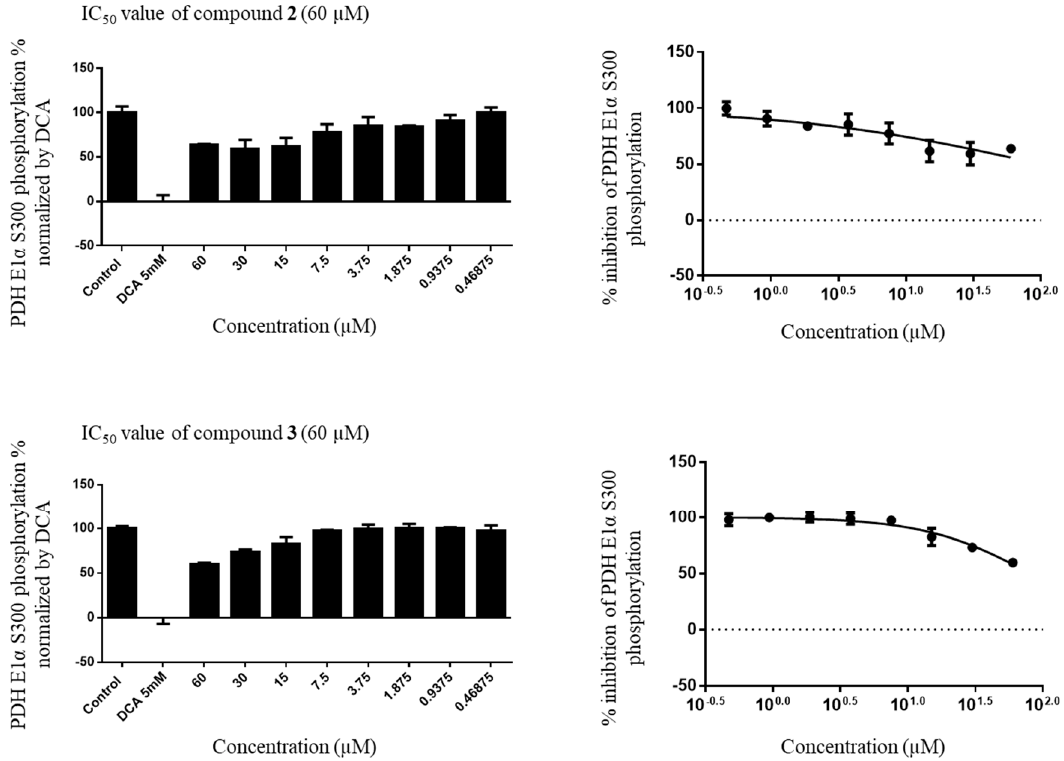
Figure 4. IC 50 value of compounds 2 and 3 .